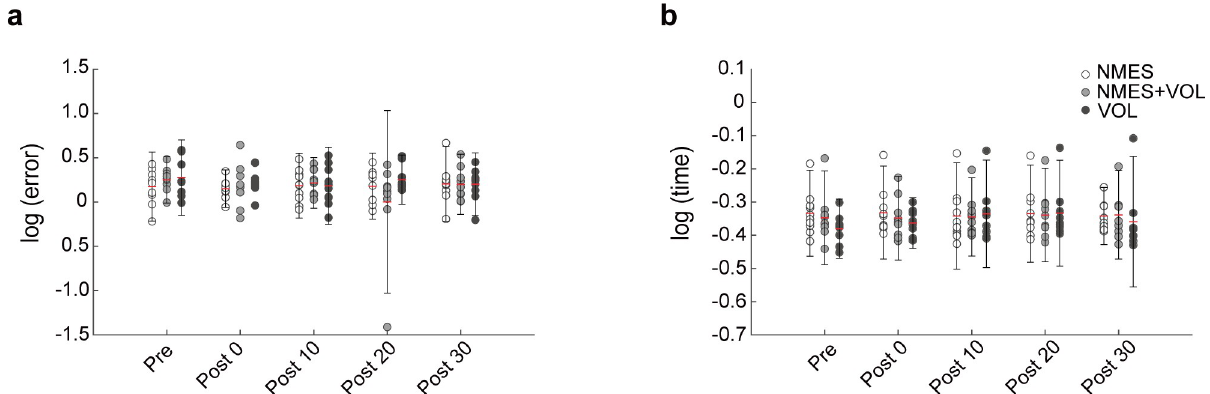
Fig 5. Changes in the motor control of ankle dorsiflexion (a) error; and (b) reaction time during force-matching task. Circles represent each individual data and error bars represent 2 standard deviation. The red lines indicate mean for each time point. Abbreviations: NMES, neuromuscular electrical stimulation; VOL, voluntary